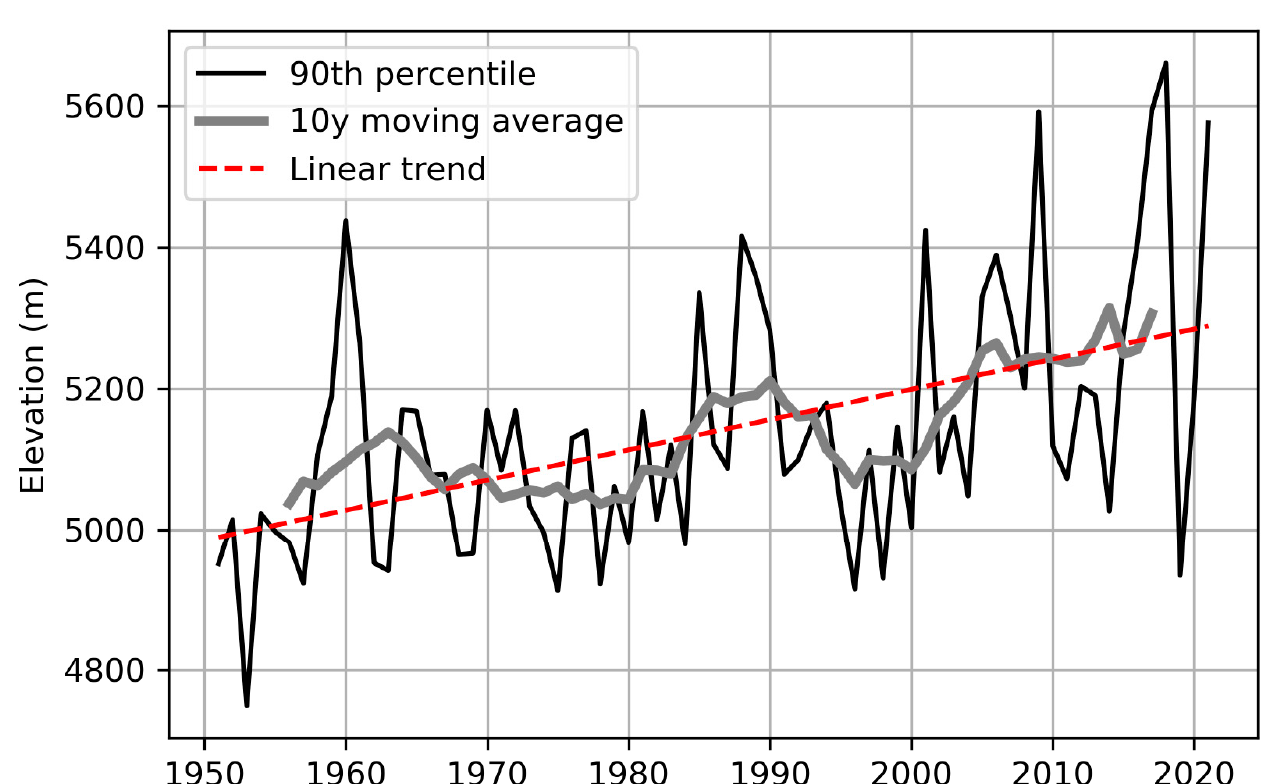
Figure 8. Mean daily maximum winter season freezing level from 1950–2021 (black line) based on bias-corrected ERA-5 temperatures (1950–2018) and observations (2019–2020) for Everest Base Camp and Camp II daily temperatures and daily lapse rate. Bold grey line is the 10-year moving average and the dashed red line is the linear trend.